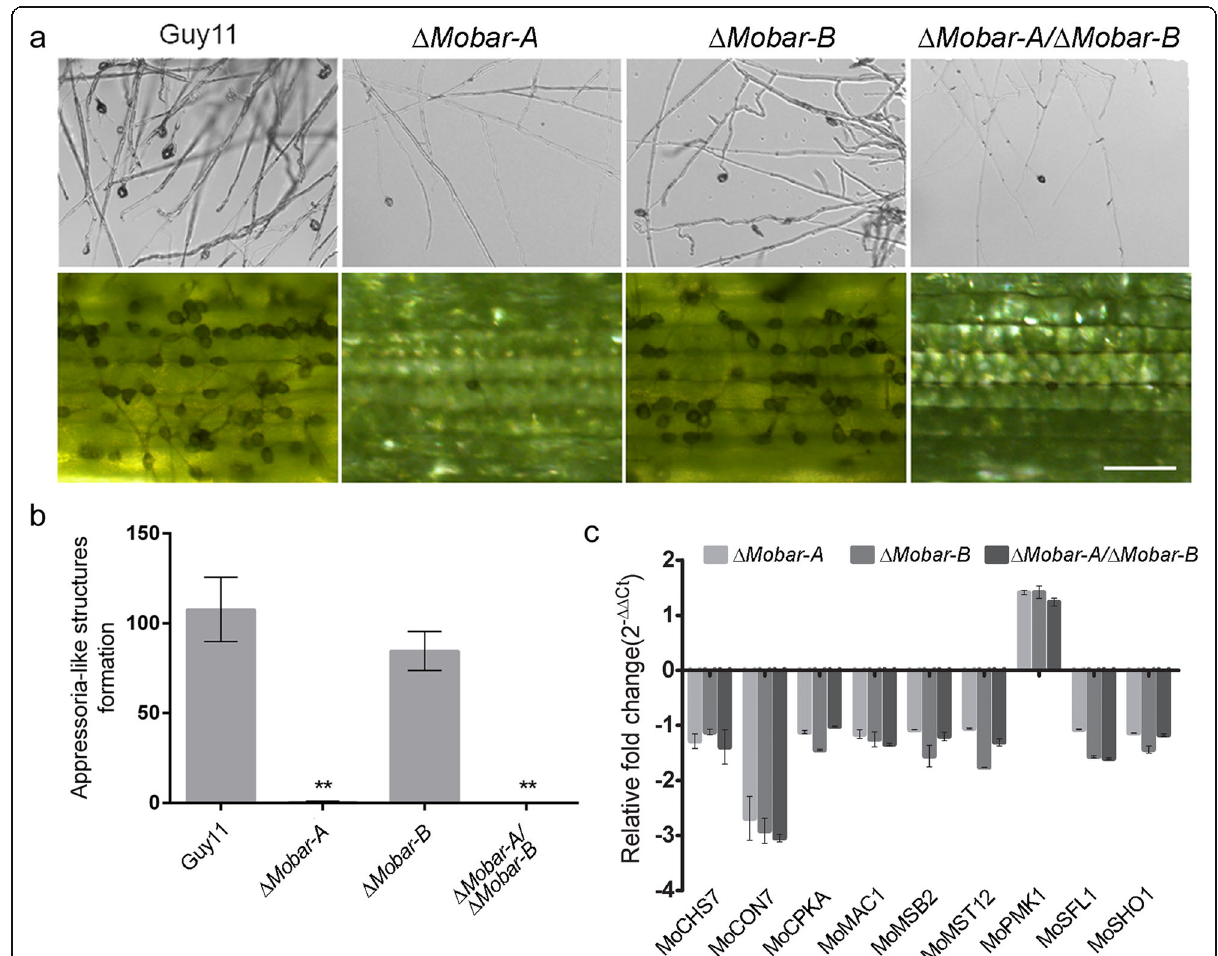
Fig. 6 MoBar-A essentially promotes the formation of appressorium-like structures in Magnaporthe oryzae. a Development of appressorium-like structures by the Δ Mobar-A , Δ Mobar-B , Δ Mobar-A / Δ Mobar-B, and the wild-type strains inoculated on artificial appressorium-inducing hydrophobic cover-slides and barley leaves. scale bar, 10 μ m. b Column digram showing the number of appressorium-like structures produced by the individual strains inoculated on barley leaves. The error bars represent standard errors from at least three independent replicates (**, P < 0.01 by t- test). c The expression level of genes associated with the formation of appressorium-like structures in the Δ Mobar-A , Δ Mobar-B and Δ Mobar-A / Δ Mobar-B strains compared with that in the wild-type strain. The qPCR results were generated from three independent biological replications with three technical replicates. The error bars represent mean ±